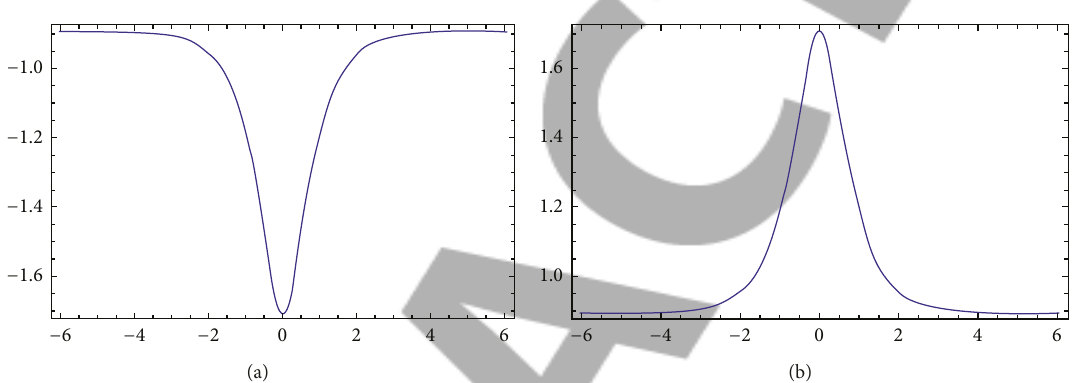
Figure 3: The simulation of solitary waves corresponding to the homoclinic orbits of (7). (a) Solitary wave of valley form. (b) Solitary wave of peak type.